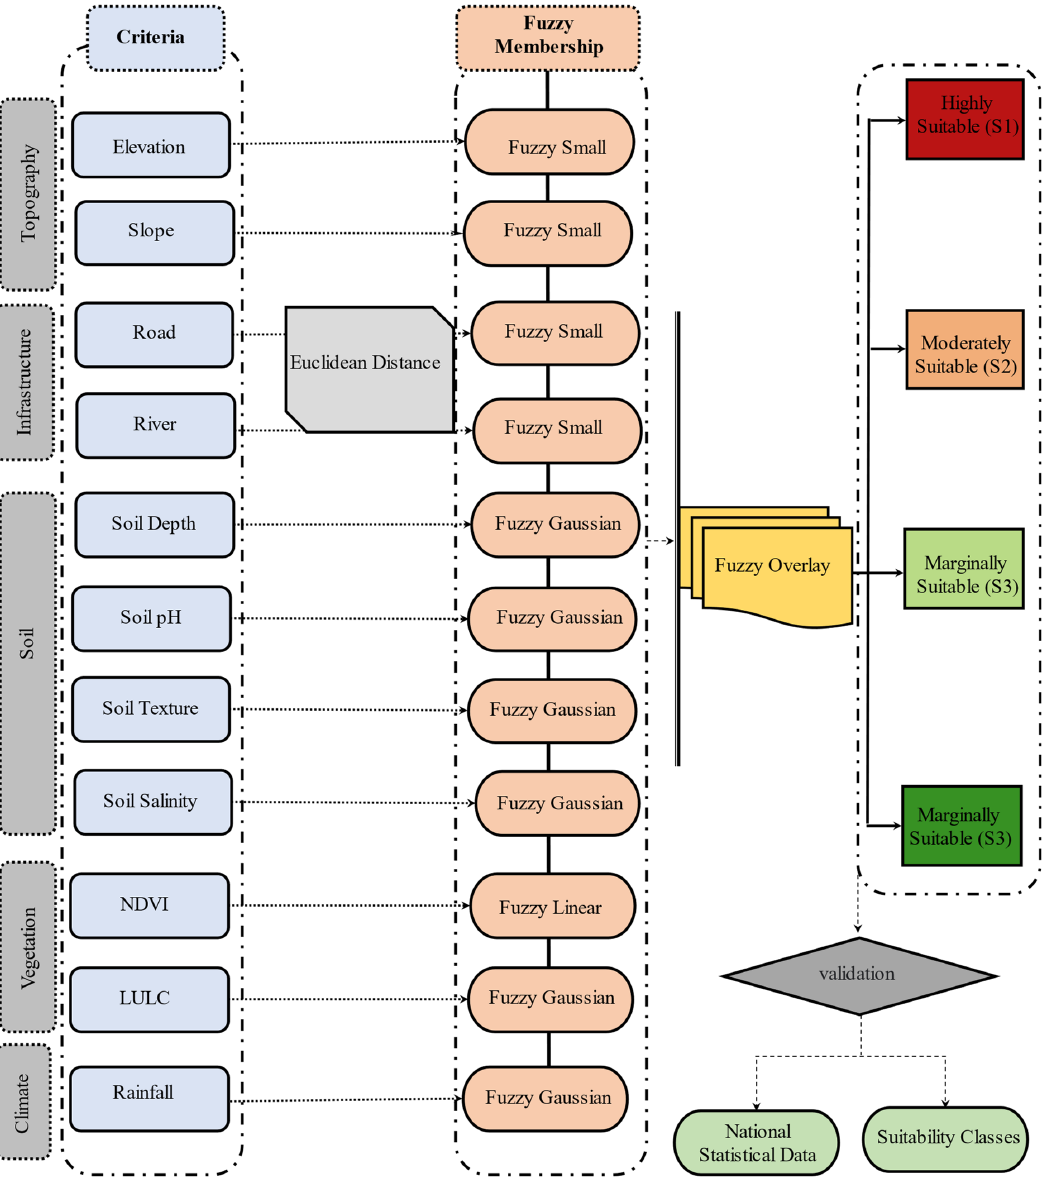
Figure 2. Research framework for vineyard suitability analysis based on a fuzzy algorithm.